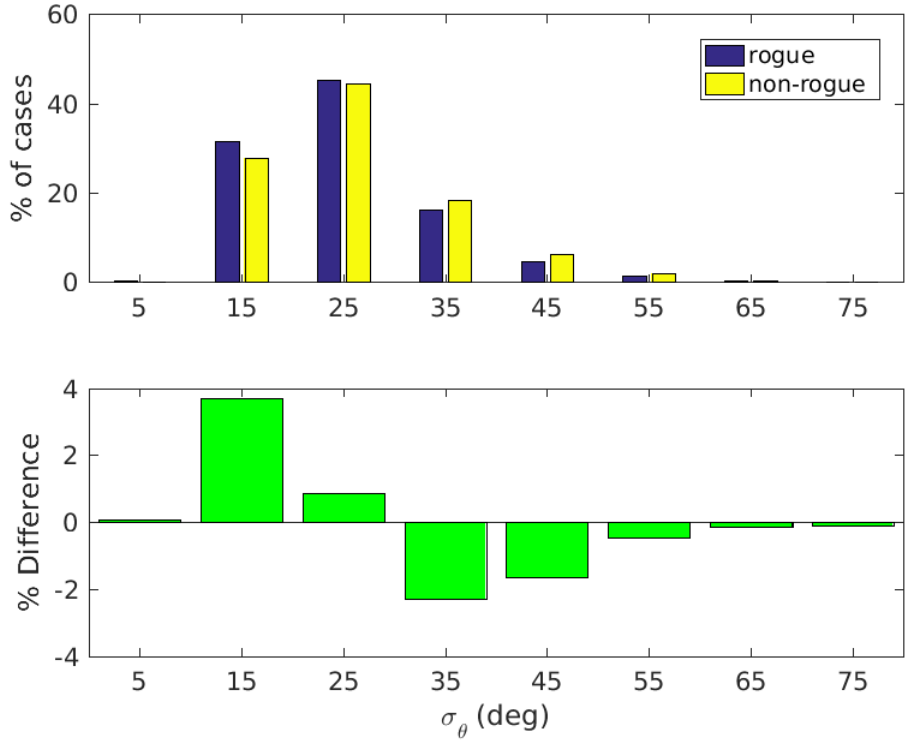
Figure 8. Comparison of directional spread ( σ θ ) probability distributions for rogue and non-rogue datasets (all buoy locations combined). Top panel : Percentage of σ θ cases in selected angle ranges for each dataset (bins centered from 5 ◦ to 75 ◦ with 10 ◦ width). Bottom panel : Di ff erence in percentage of cases in same directional spread bins. Positive values indicate a greater percentage of rogue wave events than non-rogue events for the specified bin.